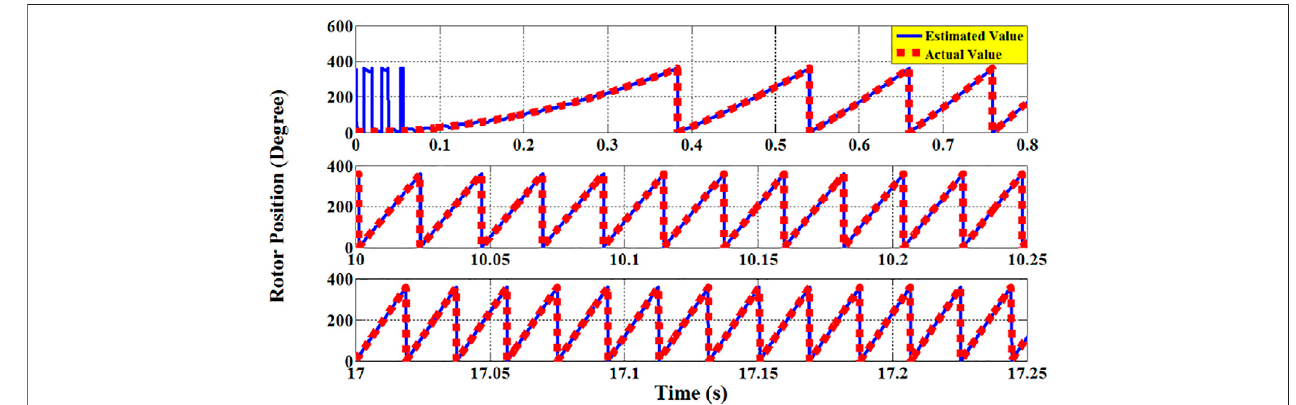
FIGURE 14 | BDFRG ’ s actual and estimated rotor-position during different periods.